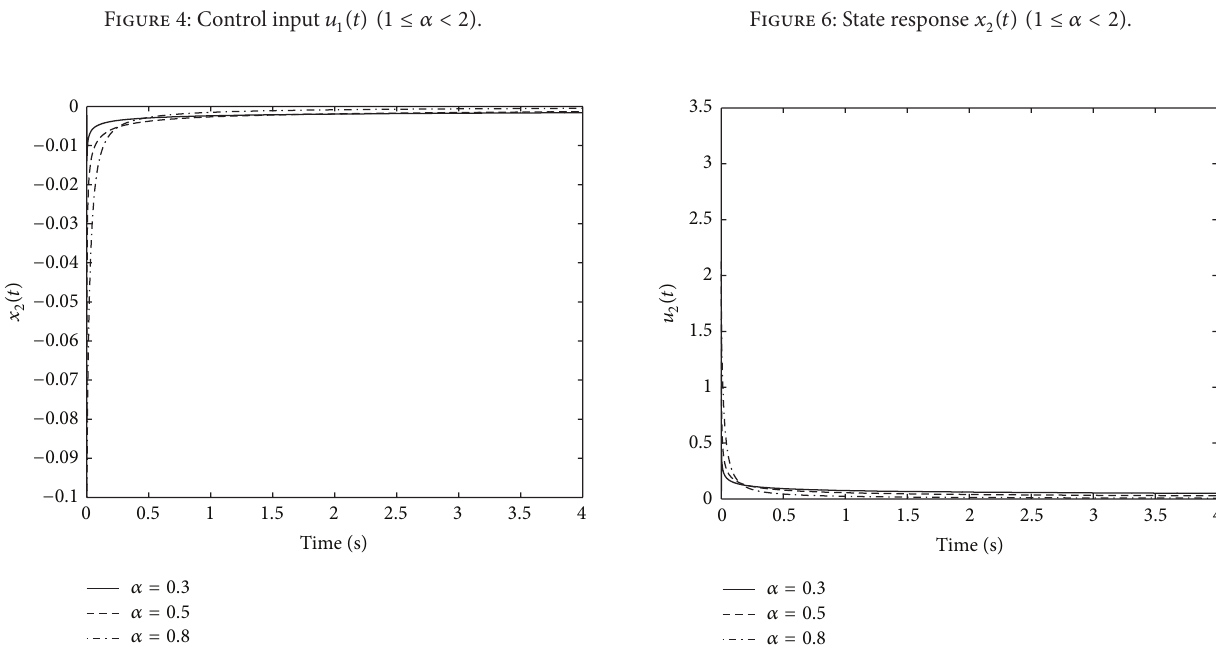
Figure 7: Control input 𝑢 2 (𝑡) (0 < 𝛼 ≤ 1)